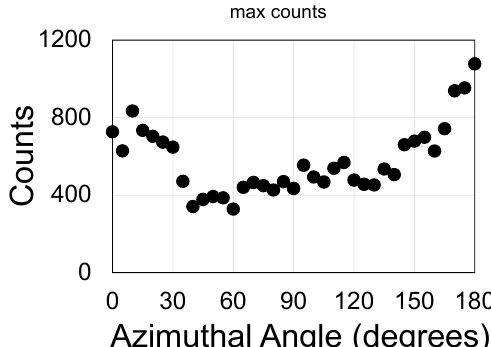
Figure 4. Variations of the peak intensity as a function of azimuthal angle, φ between the laser polarization and the hole-array orientation do not reveal a 90° symmetry; the 180° symmetry alludes to the repeatability of the rotation experiments.